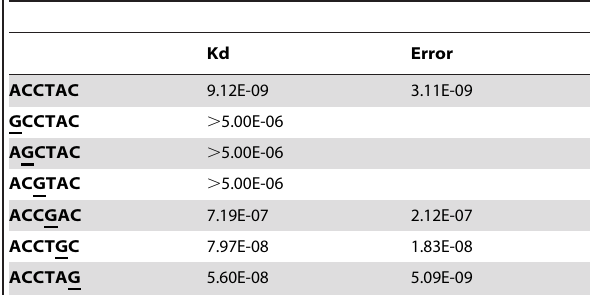
Table 3. Dissociation constants (K d ) in mol/L and associated errors of CASTing targets.